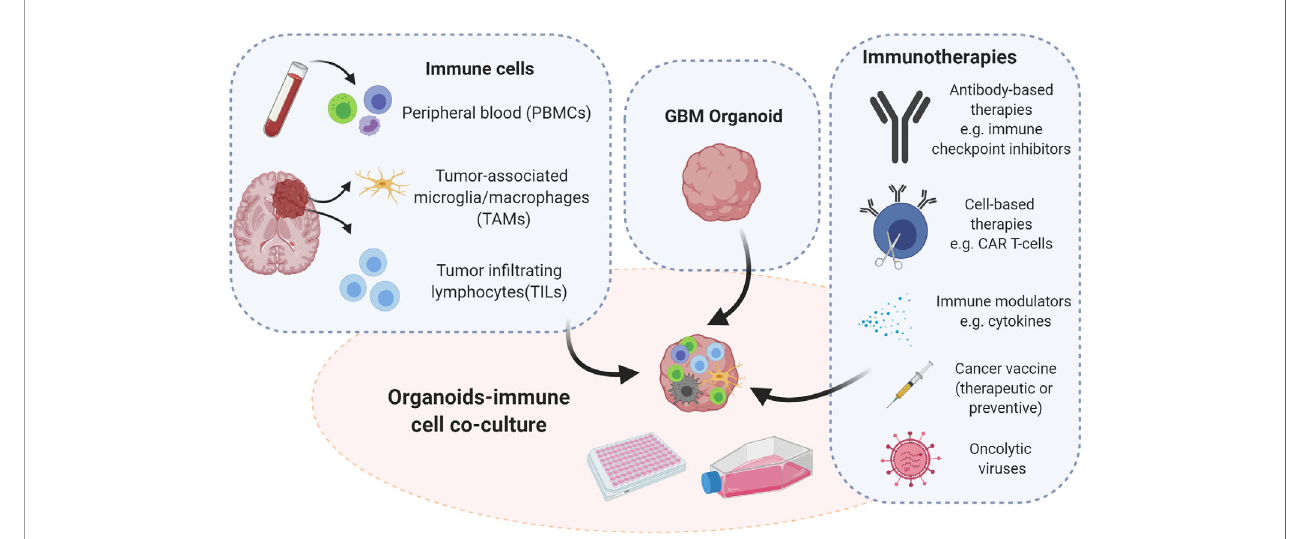
FIGURE 2 | Strategies for immunocompetent GBM organoid development. Immunocompetent organoids can be set up as co-cultures of tumor organoids with immune cells derived either from the tumor itself or from peripheral blood of patients or healthy donors. Immunocompetent organoids are applicable to functional assays and therapeutic intervention studies, which implicate assessment of tumor-immune cell interactions. Illustration created with